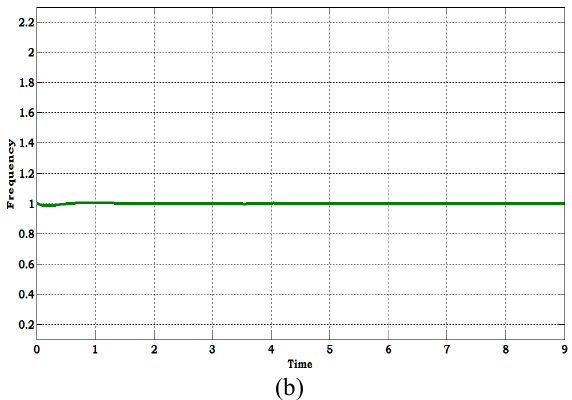
Figure 9. Waveform of(a). DC link voltage, (b). Battery Power, (c). Frequency, (d). Speed with fuzzy controller